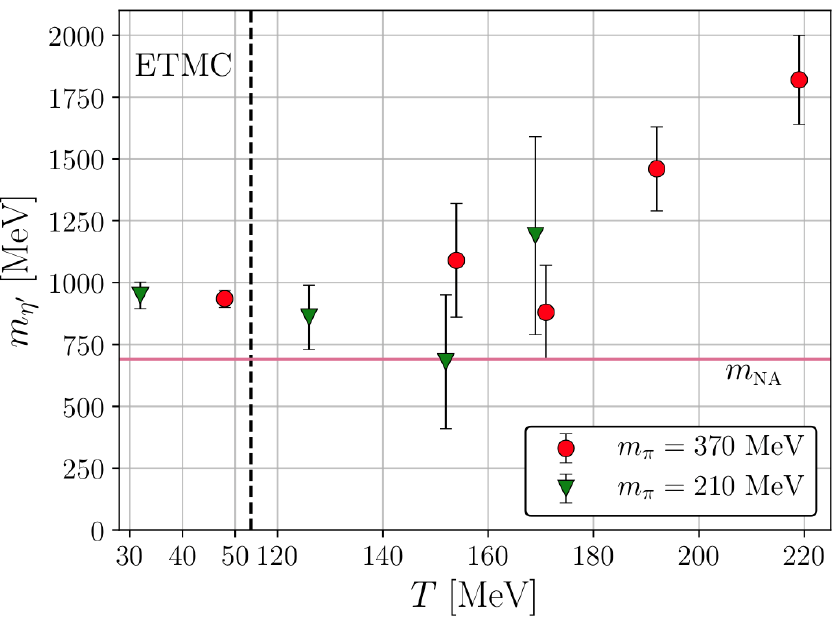
Figure 3. The mass of the η (cid:48) as a function of the temperature in QCD: the η (cid:48) mass approaches the mass of a (unphysical) ¯ ss meson at the transition, signaling the suppression of the anomalous component due to topological fluctuations. From Ref.